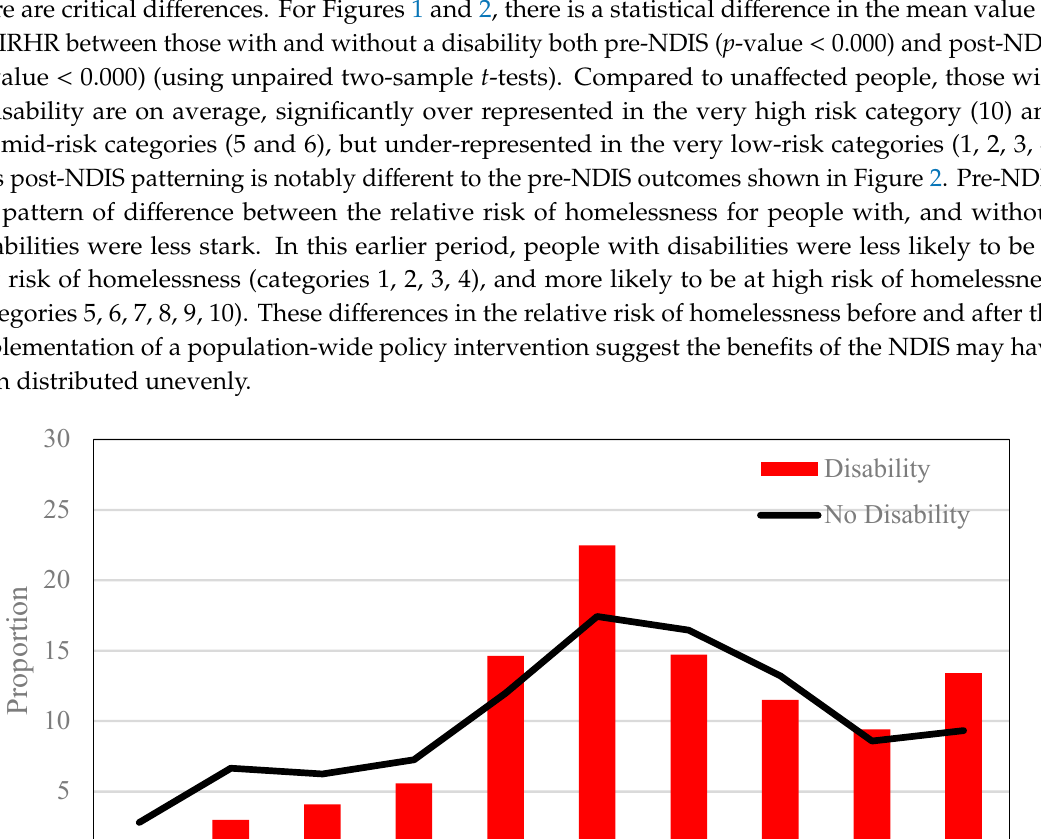
Figure 1. Index of Relative Homelessness Risk by all disability and long-term conditions versus no impairment (post-National Disability Insurance Scheme (NDIS)).